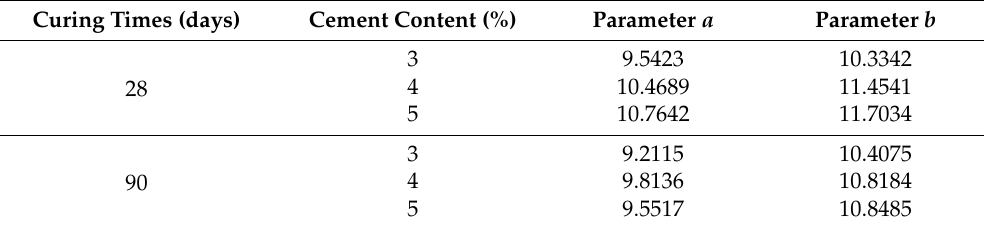
Table 10. Parameter a and b